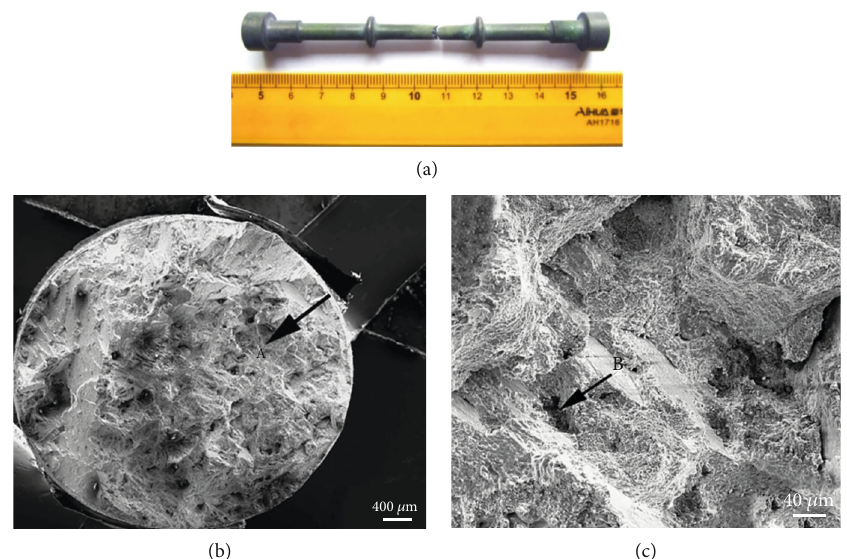
Figure 5: Sample photo and SEM images of fracture morphology of the single crystal alloy IC6SX with [111] orientation after being crept for 126.9h and then up to fracture at 850 ° C/450 MPa. (a) Fracture specimen photo; (b) low multiple fracture morphology; (c) partial enlarged image of position A from